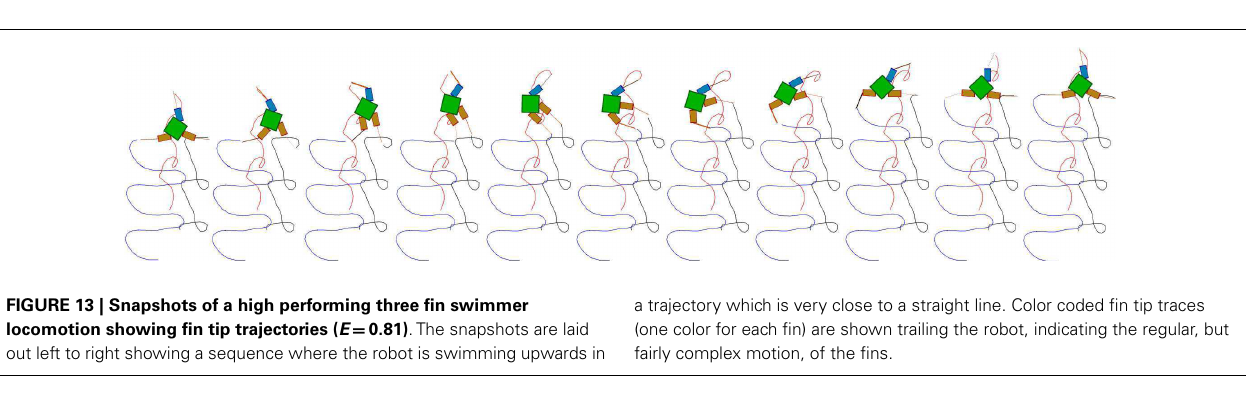
FIGURE 12 | [Left]Time course of max performance at each visit in finned swimmer exploration . Plots are color coded as in Figure 11 . [Right] Superposed image of phase difference plots from Figures 11A1,B1 .Visited points of the basic system (blue) is shown over the system with adaptation (red), and the points whose performances are higher than 0.6 are shown as